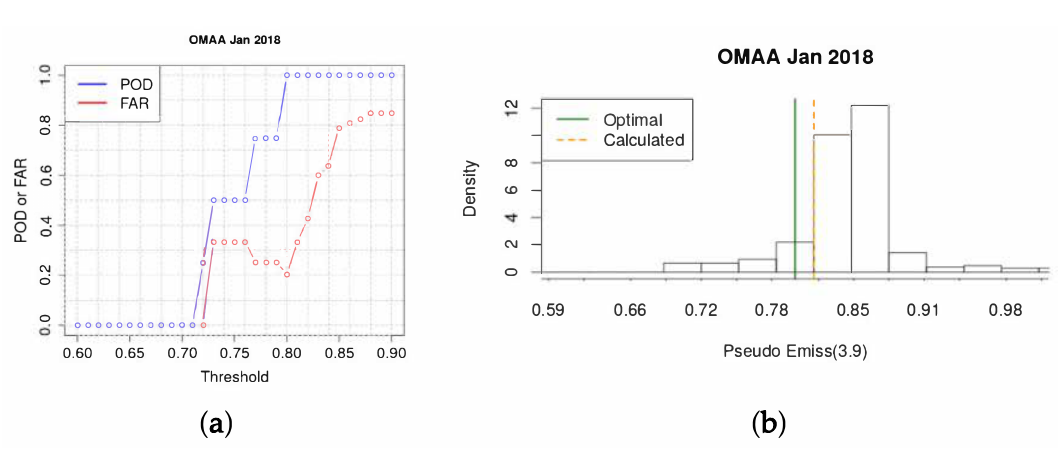
Figure 4. ( a ) Example of calculated optimal threshold at Abu Dhabi (OMAA) for January 2018. Here the optimal threshold is 0.80 (POD = 1, FAR = 0.2). ( b ) The calculated threshold was